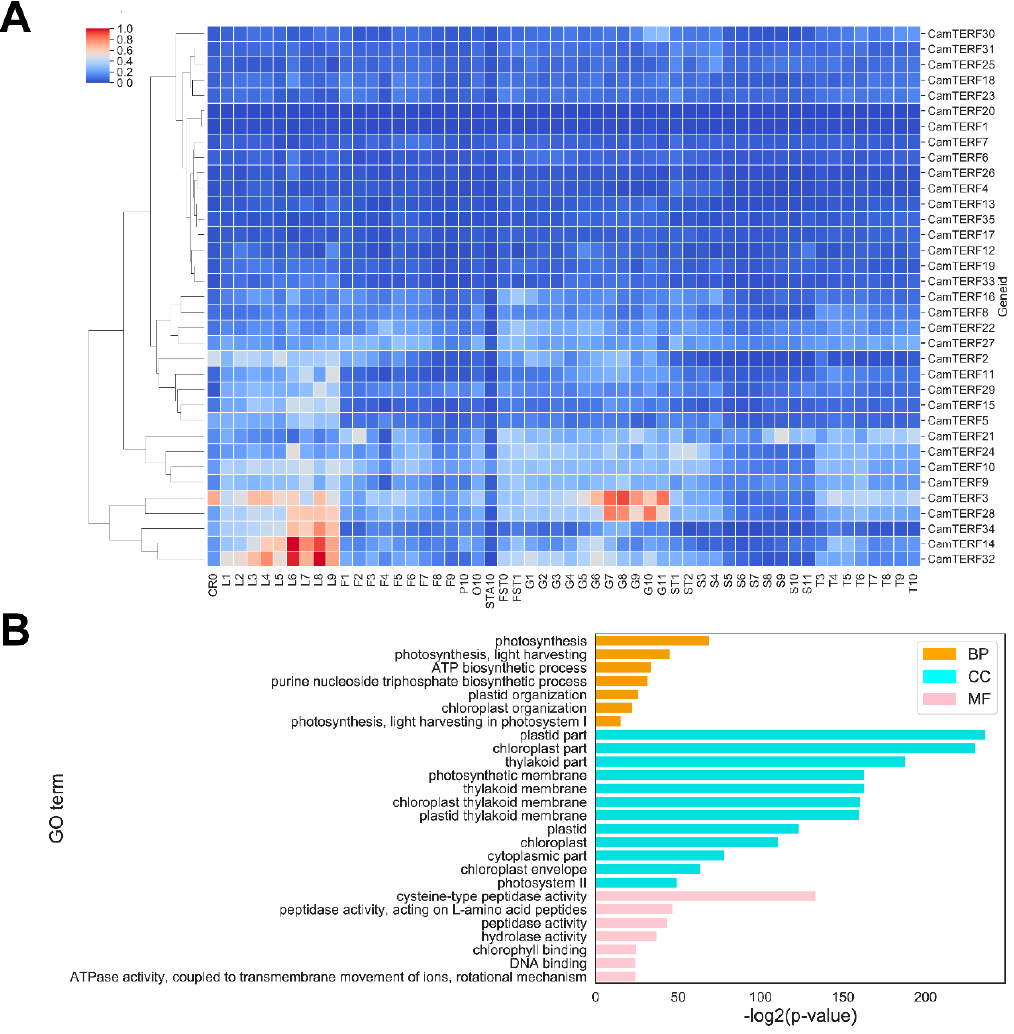
Figure 6. ( A ) Expression profiles of CamTERFs in di ff erent tissues and organs. CR0: root control; L1–L9: Leaf from 0 DAG to 50 DAG; F1–F9: Flower from 0 DAG to 50 DAG; P10: Petal; O10: Ovary; STA10: Stamen; FST0 and FST1: Whole fruit from 3 DAP and 7 DAP; G1–G11: Pericarp from 10 DAP to 60 DAP; ST1 and ST2: Placenta and Seed from 10 DAP to 15 DAP; S3–S11: Seed from 20 DAP to 60 DAP; T3–T10: Placenta from 20 DAP to 60 DAP. DAG: Days after germination; DAP: Days after pollination; ( B ) Analysis of gene ontology (GO) enrichment for co-expressing CamTERFs . GO term categorization includes biological process (BP), cellular component (CC), and molecular function (MF).